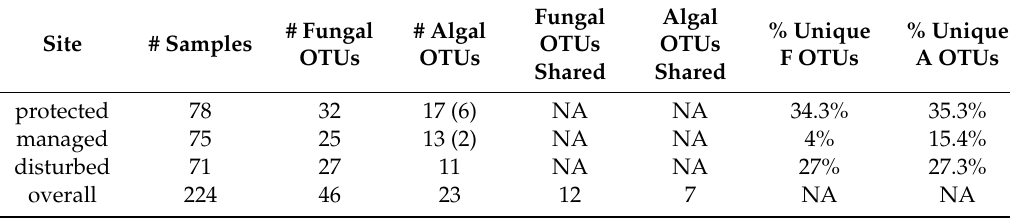
Table 1. OTUs recovered from the forest lichen